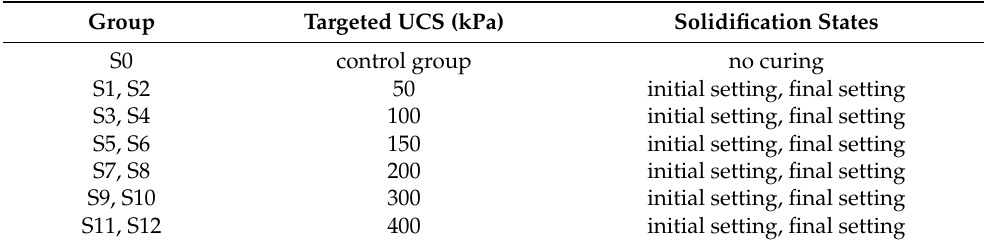
Table 4. SSRT testing scheme for the solidified soil. Group Targeted UCS